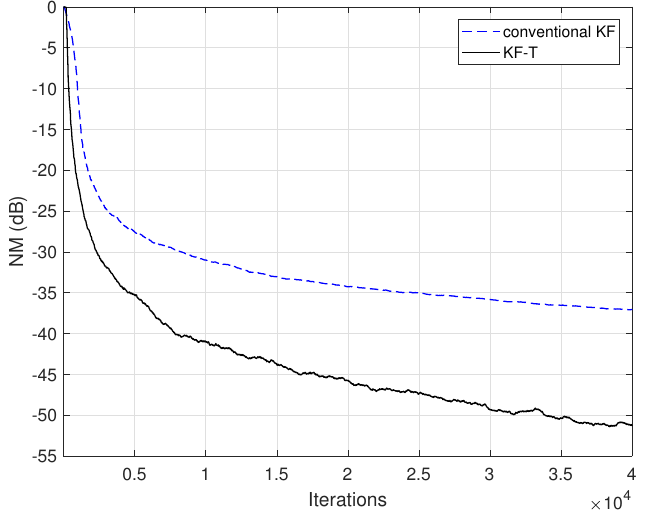
= 0, n = 1,2, . . . , N and the n